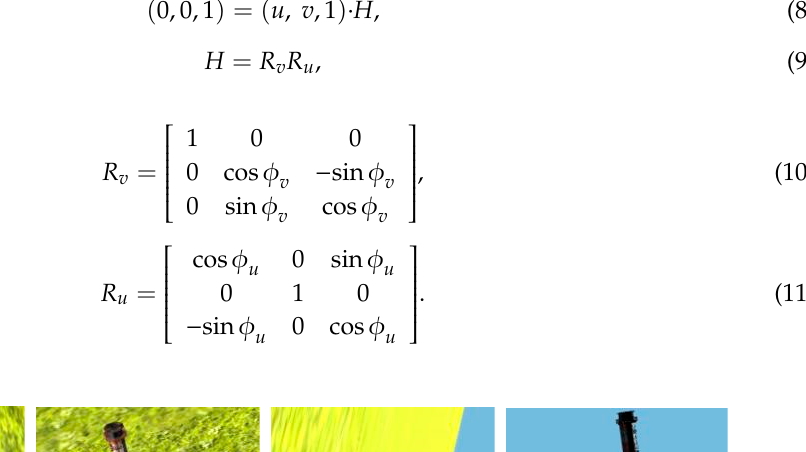
Figure 6. Homography transformation for translation of the object origin projection to the image center.